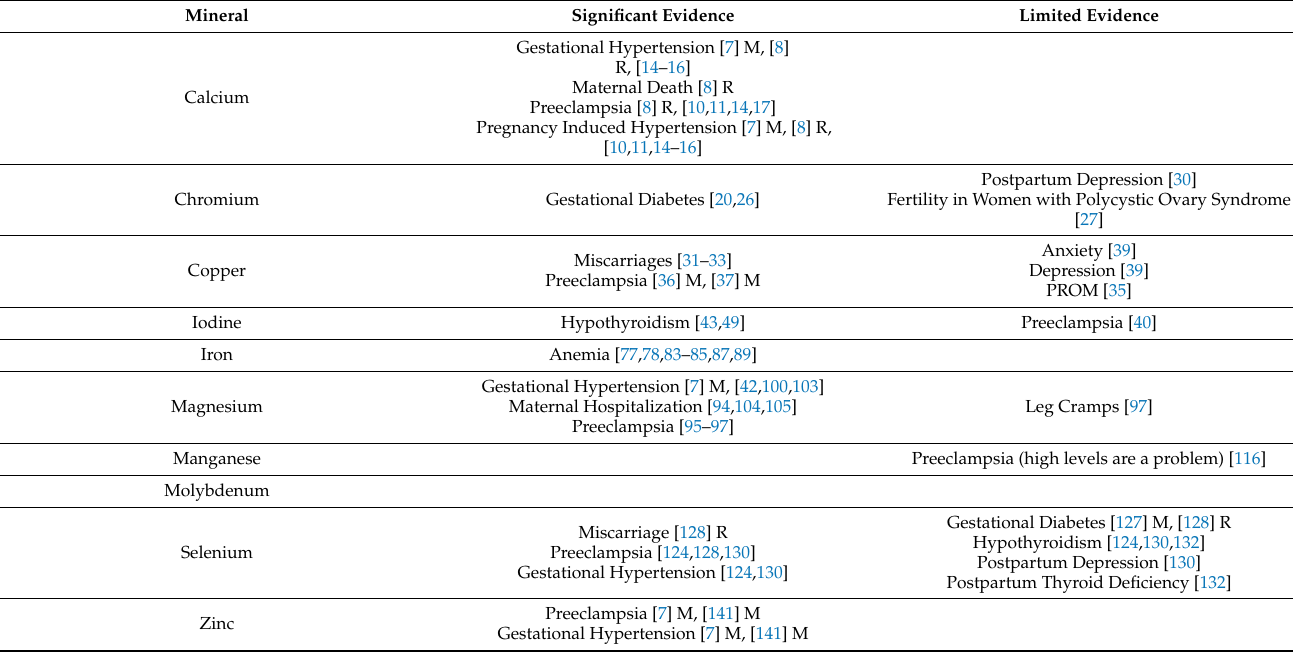
Table 3. Relationship of minerals to maternal health problems/benefits [7,8,10–17,20,26,27,30–33,35–37,39,40,43,49,77,78,83–